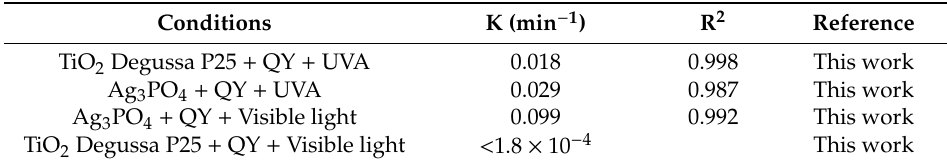
Table 2. QY degradation rate constants (k) using Ag 3 PO 4 (0.5 g · L − 1 ) or TiO 2 Degussa P25 (0.5 g · L − 1 ) as a photocatalyst.